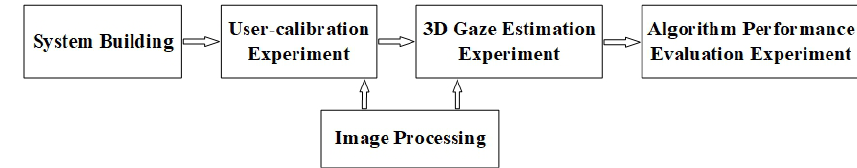
Figure 11. Experimental procedures on the actual system.